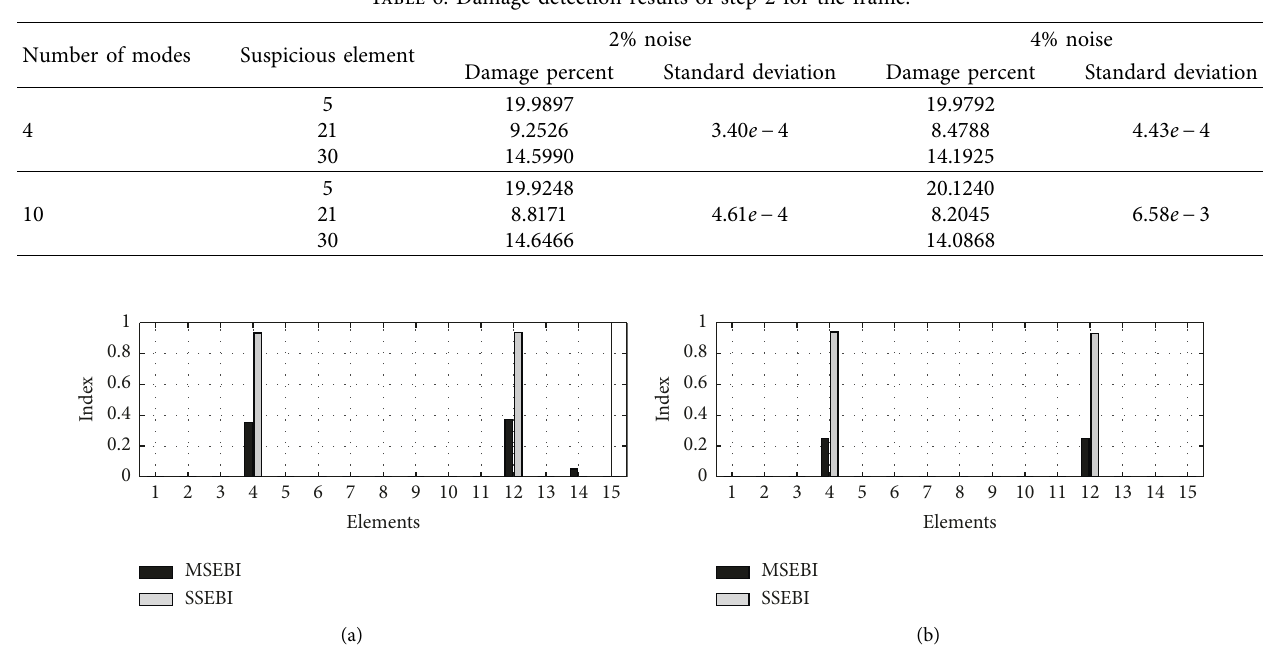
Figure 10: Damage detection results for the cantilever beam in the first step using MSEBI index and SSEBI index; (a) results obtained using the first mode, (b) results obtained using the first five